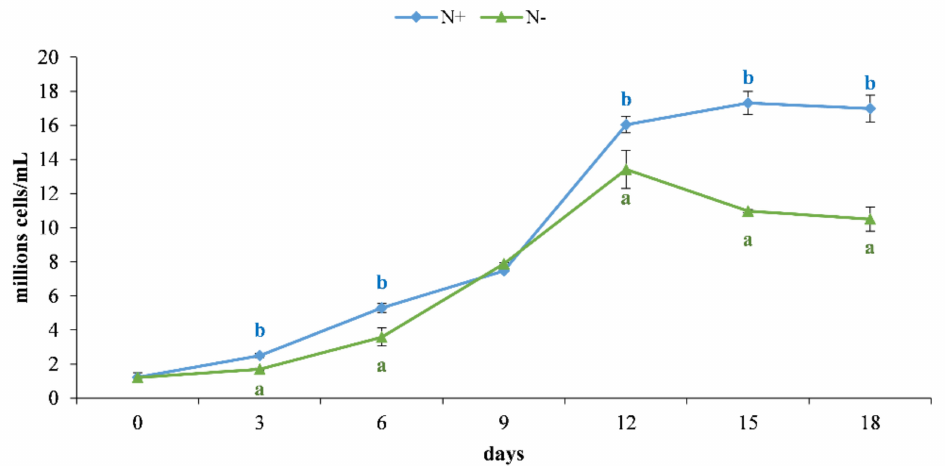
Figure 2. Growth performance of P. tricornutum cultivated for 18 days under standard (N+, blue line) and starvation condition (N − , green line). Values are presented as the mean ± SEM ( n = 3) with standard deviations. Different letters within the same day indicate significant differences ( p <